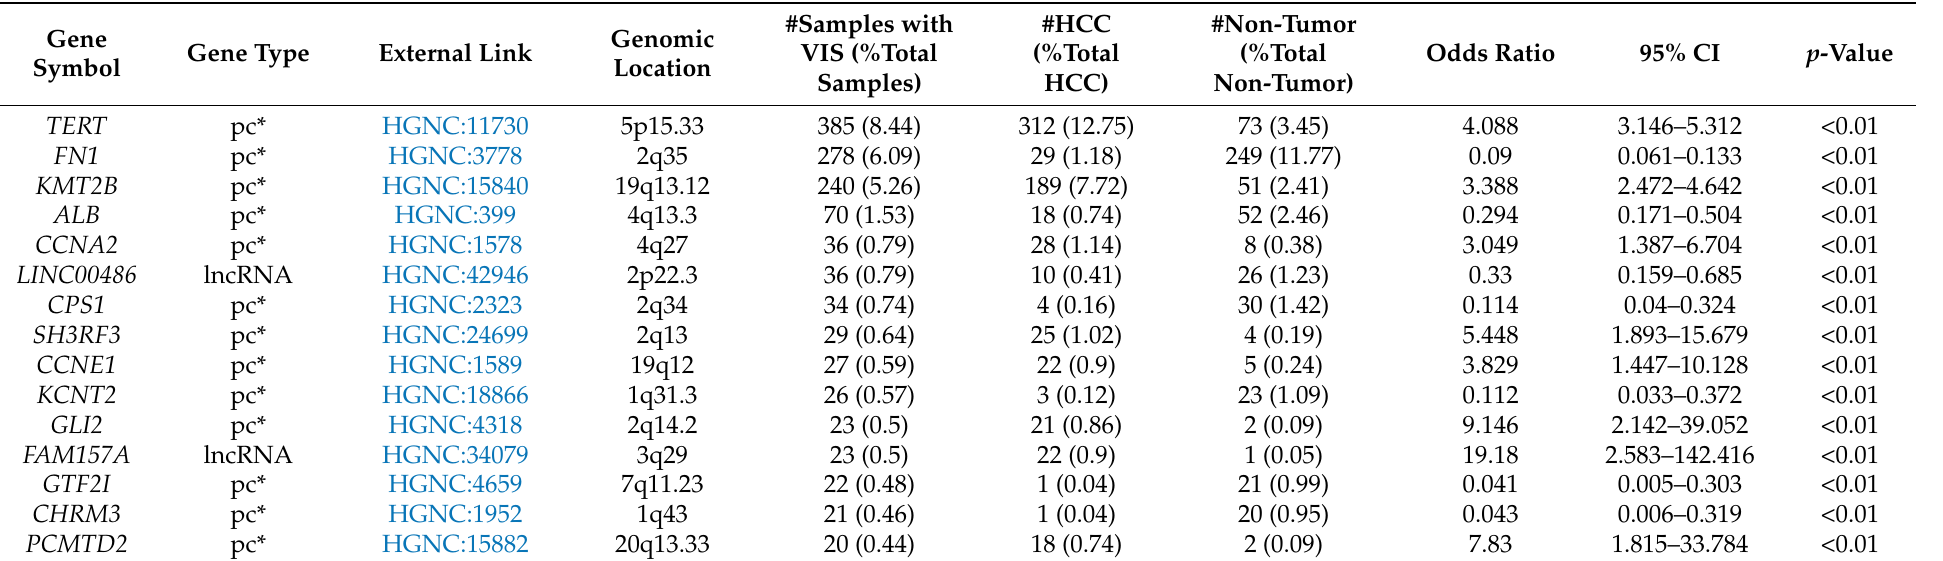
Table 2. Association between HBV DNA integrations and HCC in 15 target human